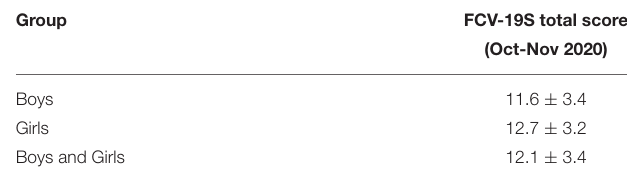
TABLE 4 | Descriptive statistics of the Fear of COVID-19 Scale (FCV-19S) scores collected during the pandemic (October-November 2020).